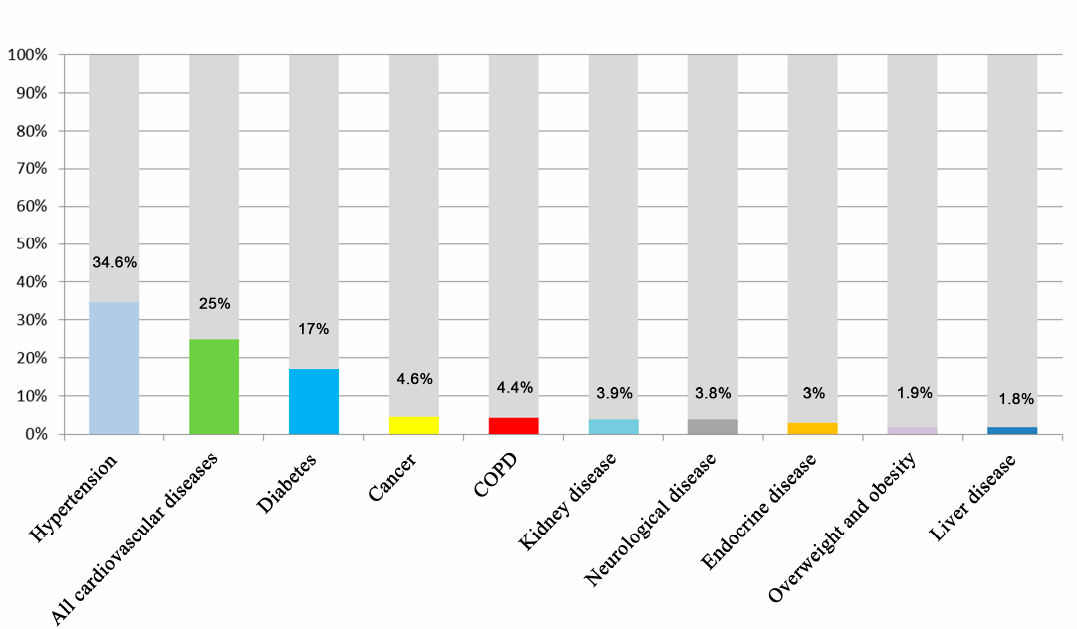
Figure 2. The histogram summarizes the comorbidity data in patients who died with COVID-19. Data are indicated in percentage for each comorbidity. Notably, percentage was obtained by indicating as the numerator the number of patients died who were positive for COVID-19 and affected by the specific comorbidity and, as the denominator, the total amount of patients who died and were positive for COVID-19.